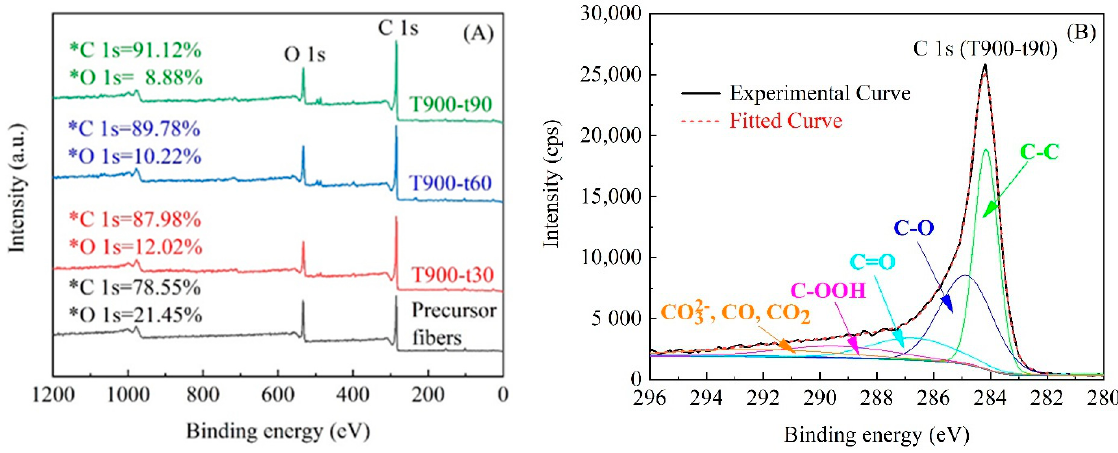
Figure 5. XPS spectrum of ACFs ( A ) and curve fitted high resolution XPS scans of T900-t90 for C1s ( B ).